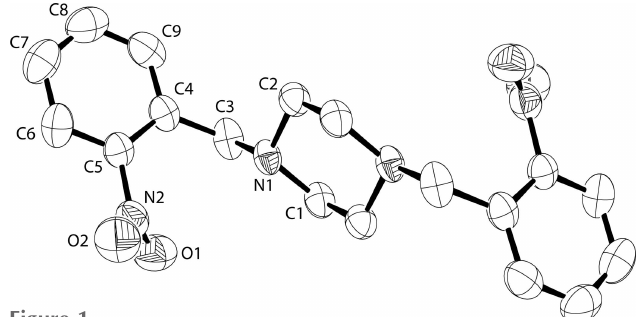
Figure 1 The molecular structure of the title compound with displacement ellipsoids drawn at the 50% probability level. Unlabelled atoms are generated by the symmetry operation (1 (cid:4) x , (cid:4) y , (cid:4) z ) and H atoms are omitted for clarity.